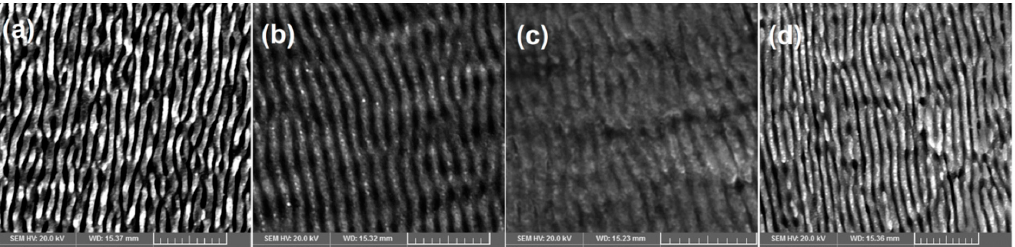
Figure 3. Scanning electron microscope ( SEM ) images of the processed ( a ) stainless steel, ( b ) copper, ( c ) aluminum, and ( d ) brass surfaces. The scanning speeds for stainless steel, copper, aluminum, and brass were 350, 400, 500, and 450 mm/s respectively. The laser beam direction is perpendicular to the Laser Induced Periodic Surface Structures (LIPSS) orientation. The scale bar for all images is 5 µm.